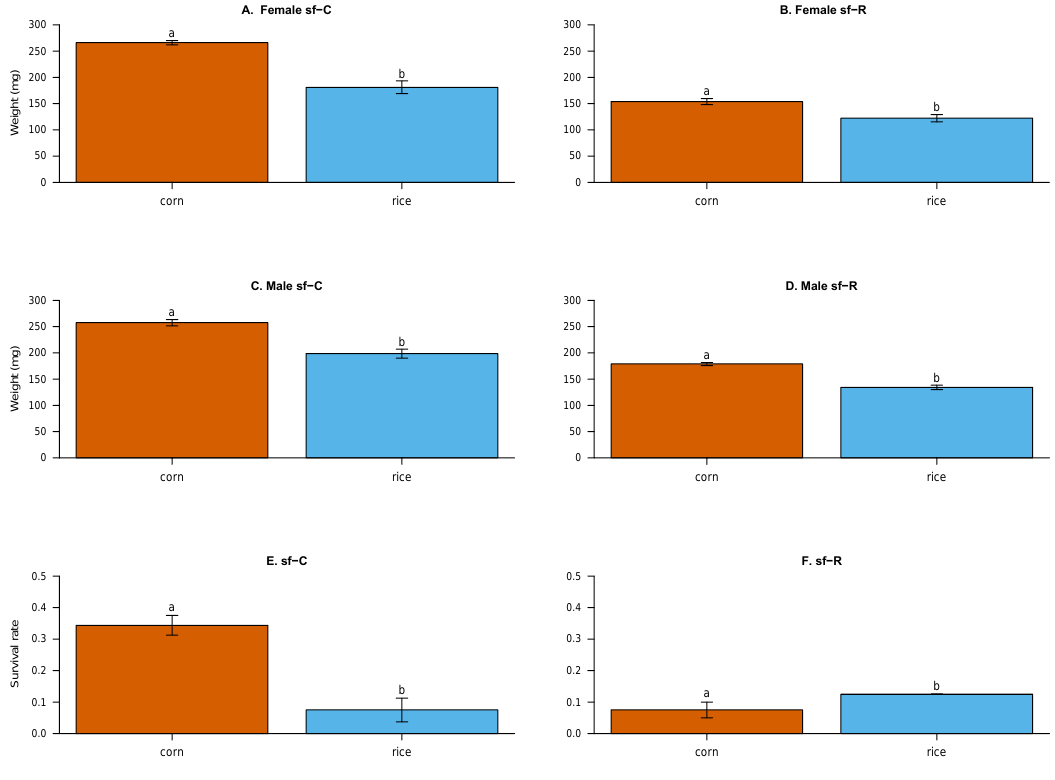
Figure 2: Fitness traits of sf-C and sf-R according to the diet. (A-D) Pupal weight (wt) is measured in duplicate for sf-C (A-C) and sf-R (B-D) according to plant diet: corn (red) and rice (blue). We measured separately females (A-B) and male (C-D) pupae. The survival (sv) rate (E, F) is measured from the 1st larval instar to adult emergence for sf-C (E) and sf-R (F) according to plant diet. Bars represent the mean of survival rate of the two experimental replicates with the standard error. Different letters above bars indicate significant differences of survival between plant diets for each strain (P <